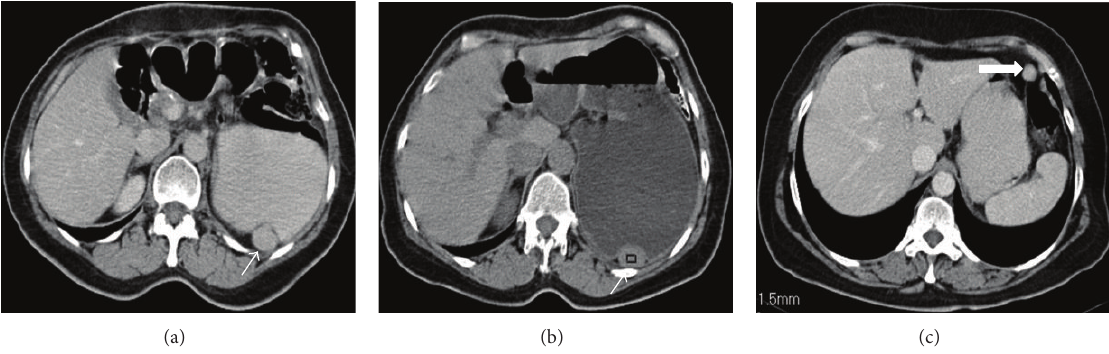
Figure 5: Accessory spleens can locate at the wall of stomach or bowel. Axial contrast-enhanced CT image (a) with oral contrast medium shows a nodular hyperdense lesion (arrow) indenting the posterior wall of the stomach in a 57-year-old female patient. The follow-up axial nonenhanced image (b) with oral water shows persistence of its high density indicating an accessory spleen. Axial contrast enhanced CT image (c) shows an accessory spleen located closely to the colonic wall (thick arrow).